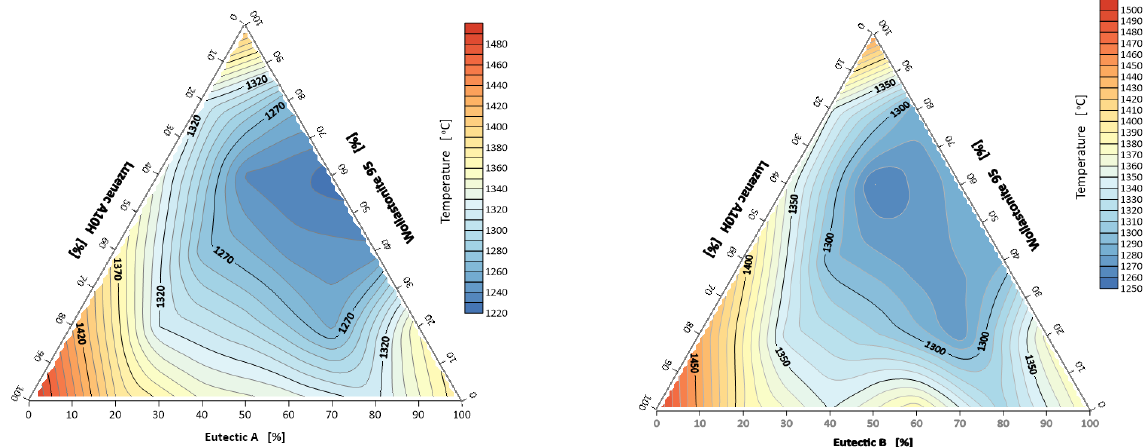
Figure 4. System spreading (flow) temperature: A/B-eutectic–Luzenac A10H–Wollastonite 95. The study showed that the melting temperature of the different sets with A and B eutectic measured as the point of hemisphere formation between the two composition triangles did not differ